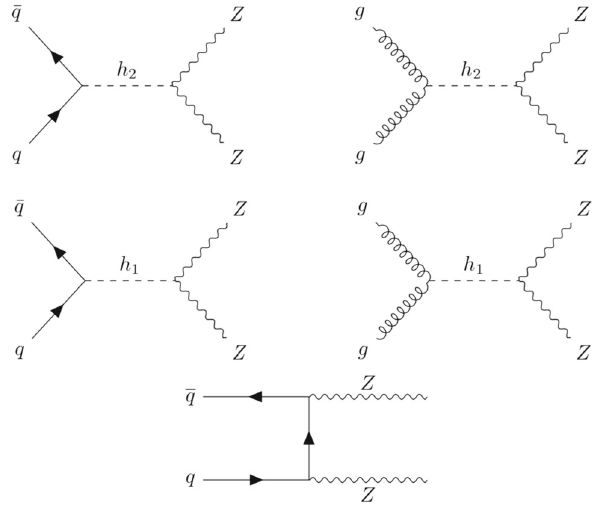
Fig. 7 The leading order Feynman diagrams for the signal process ( a ) and the main background process ( b ) Table 2 Pre-selection cuts for identifying the leptons ( l = e or μ ) Quantity Selection criteria Transverse momentum p l